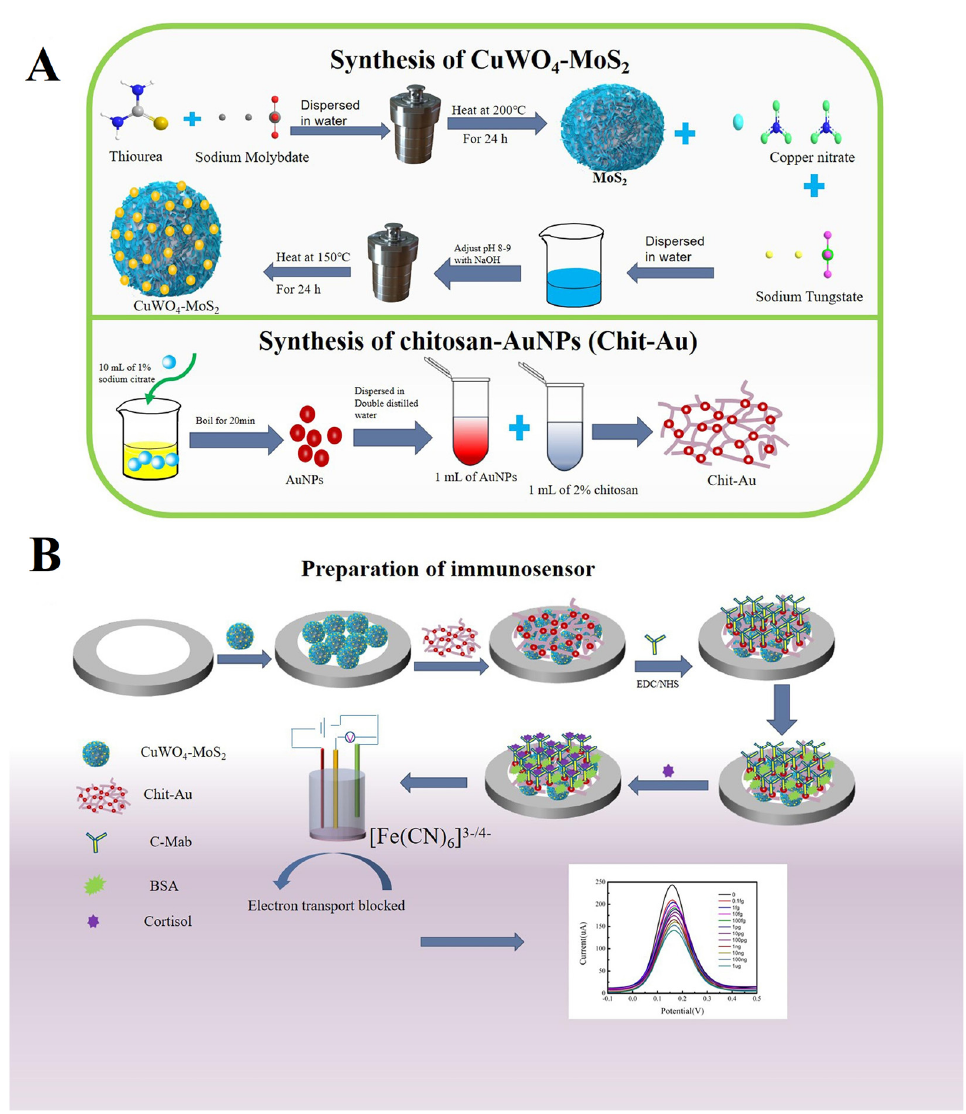
Figure 14. Schematic representation for ( A ) Synthesis of MoS 2 , CuWO 4 @MoS 2 , AuNPs, and Chit-Au nanocomposites; ( B ) Preparation process of the immune electrode. Reprinted with permission for Ref. [80] . Copyright 2022, Elsevier.